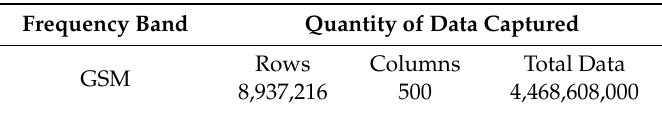
Figure 1. Experimental configuration for measuring spectral occupancy.